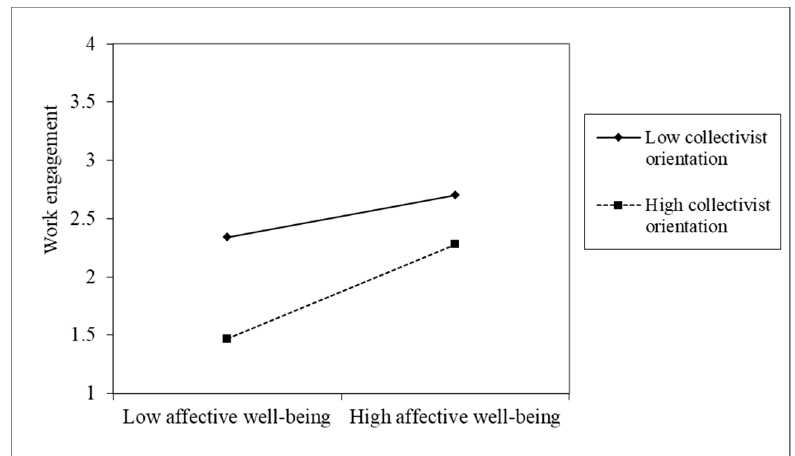
Figure 2. Effect of the interaction between affective well-being and collectivist orientation on work engagement.